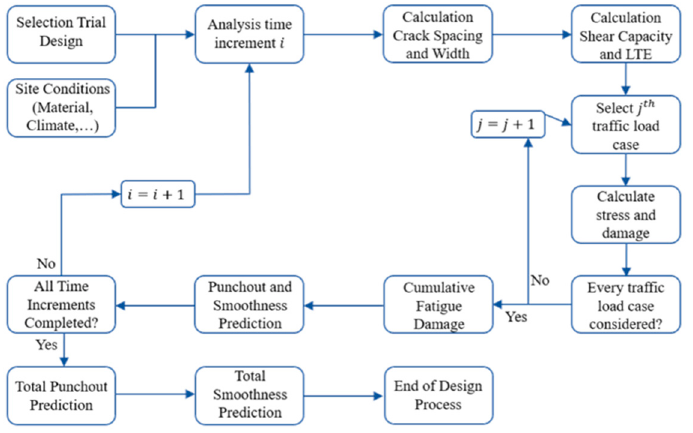
Figure 8. The procedure for dimensioning according to the MEPDG